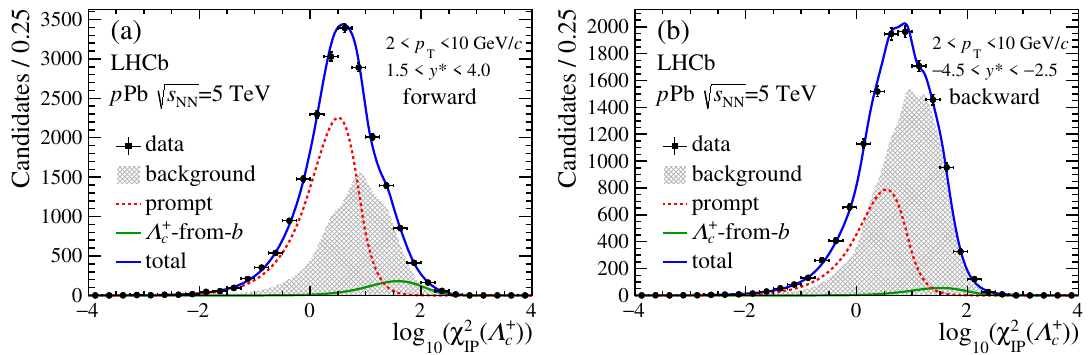
Figure 2 . Distributions of log (cid:31) 2 ( (cid:3) + ) in the range 2 < p T < 10 GeV =c with the (cid:12)t results overlaid 10 c IP for (a) the forward data sample with 1 : 5 < y (cid:3) < 4 : 0, and (b) the backward data sample with (cid:0) 4 : 5 < y (cid:3) < (cid:0) 2 : 5. The solid blue curve is the sum. The red dotted line is the prompt component, the green is the (cid:3) + -from- b component and the grey shaded area denotes the combinatorial c